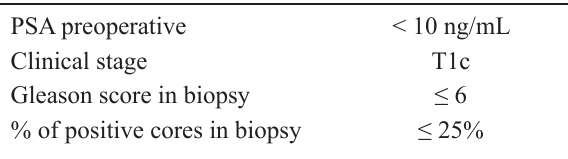
Table 1 – Definition of clinically insignificant prostate